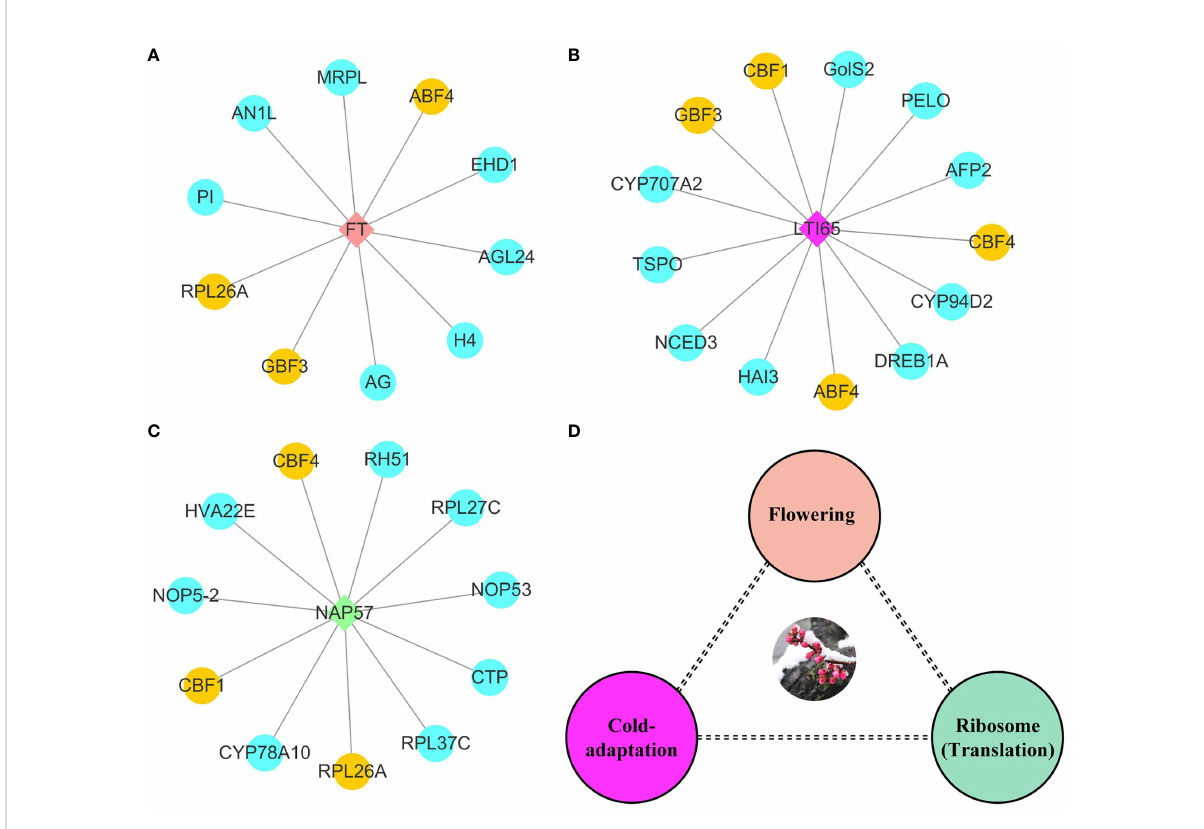
FIGURE 6 Potential hub regulatory protein interactions and models for early fl owering traits. (A) Interaction network with FT as hub protein in early fl owering associated proteins. (B) Interaction network with LTI65 as hub protein in early fl owering associated proteins. (C) Interaction network with NAP57 as hub protein in early fl owering associated proteins. The yellow represents shared proteins in the three interaction networks. The blue represents the unique proteins in each interaction network. (D) Potential models for regulating fl owering